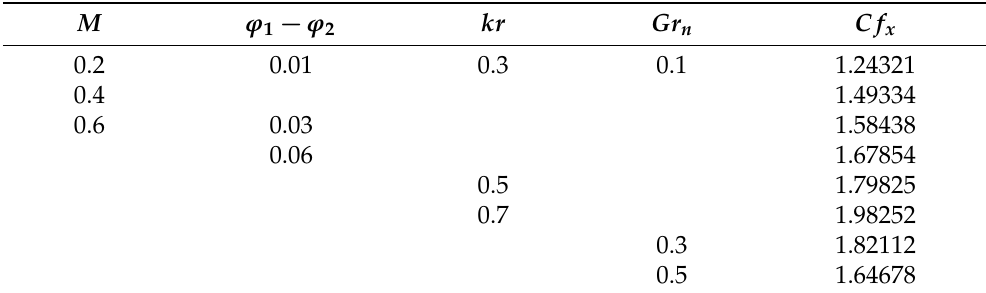
Table 2. Variations in the Cf x Re 0.5 x values under the impact of different